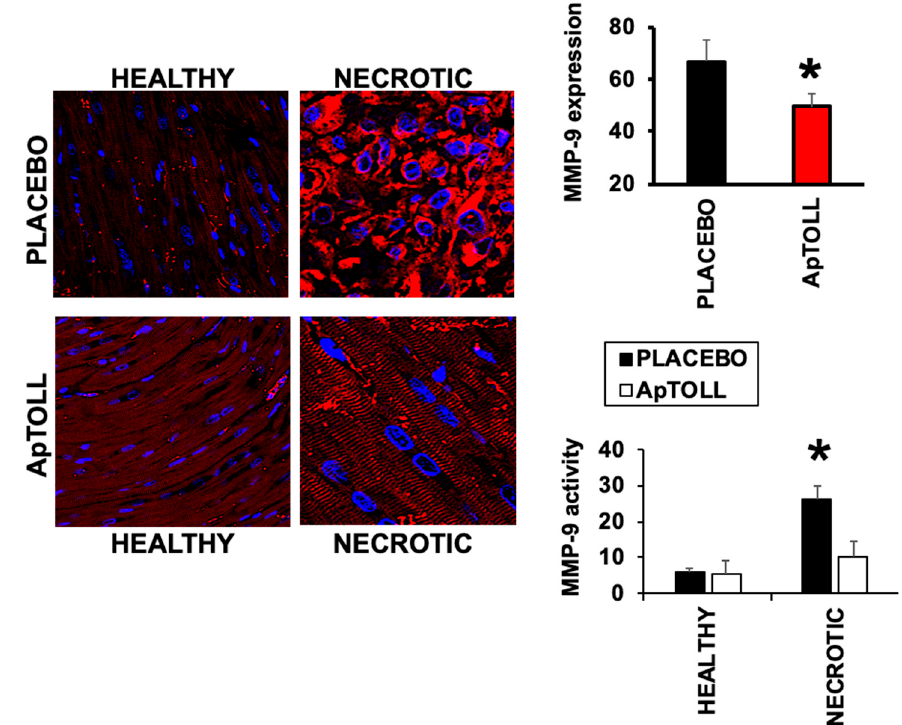
Figure 4. Confocal microscopy detection of Matrix Metalloprotease 9 (MMP-9; red) in heart sections of pigs treated with 0.078 mg / kg ApTOLL or Placebo, 7 days after IR. Nuclei were stained with DAPI (N = 5 ApTOLL / 4 Placebo. Mean ± SD. * p < 0.001 Placebo vs. ApTOLL). Lower graph. MMP-9 activity assay in the same hearts (N = 3 / condition. Mean ± SD. * p < 0.004 Necrotic Placebo vs. Necrotic ApTOLL).